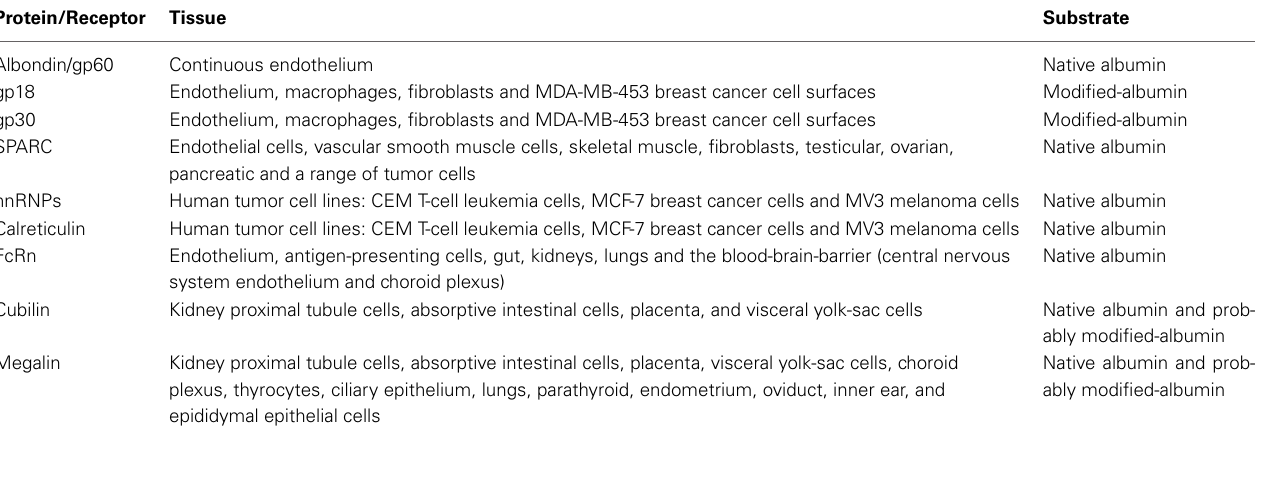
Table 1 | Localization of albumin-binding proteins and receptors. Protein/Receptor Tissue